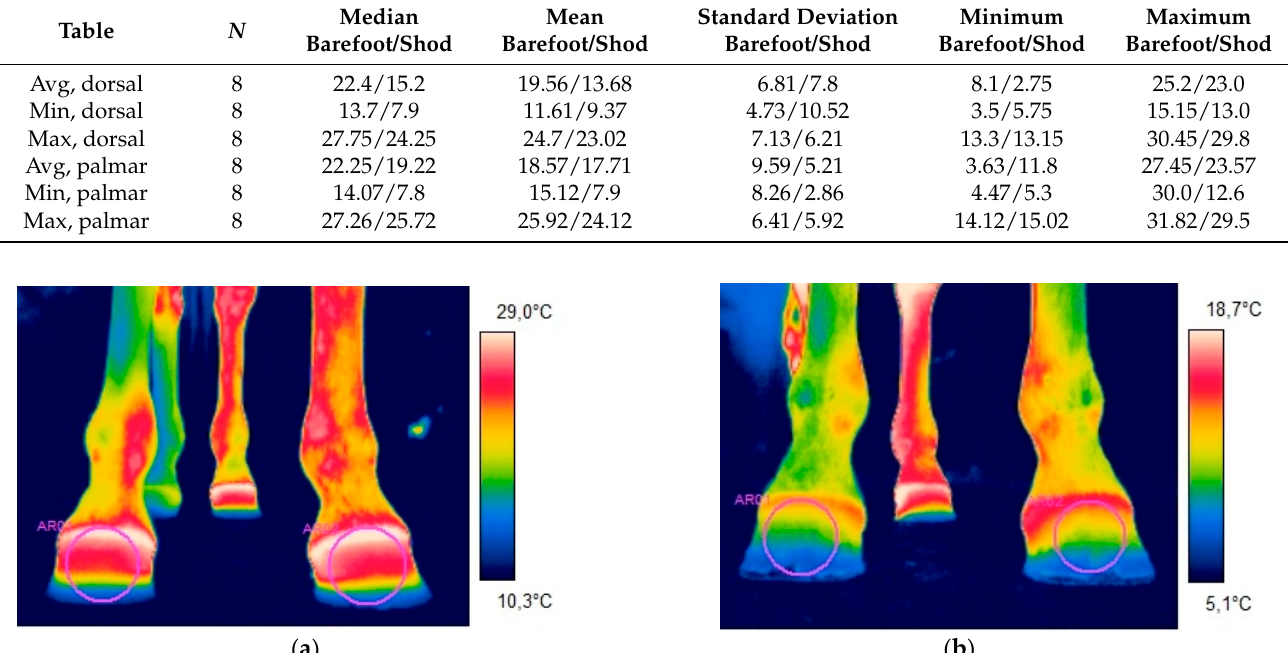
Figure 1. Thermographic image representing the dorsal aspect of the front limbs of a five-year-old Polish halfbred gelding before ( a ) and after ( b ) shoeing with egg bar shoes. The measurements were taken from the left limb, the area of which is marked by a circle. It is clearly visible, based on the color map, that the limb after shoeing was cooler. This was proven with the results of the measurements. The mean temperature decreased from 23.3 °C before shoeing to 5.05 °C after shoeing. Table 1. Thermographic results received from group 1 before and after shoeing with egg bar shoes. Avg, average temper- ature; Min, minimum temperature; Max, maximal temperature.